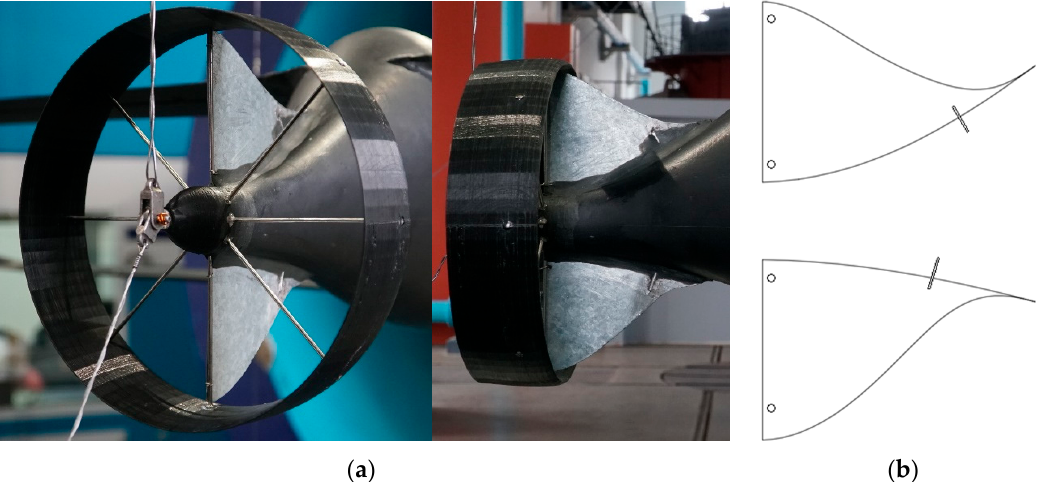
Figure 24. ( a ) Wind tunnel model of the final configuration with a tail duct and vertical fishtail fins with a large surface attached to it. ( b ) Attachment was through a 1.7 mm pin inserted in the fuselage and through metal wires tied to the vertical duct metallic spokes.